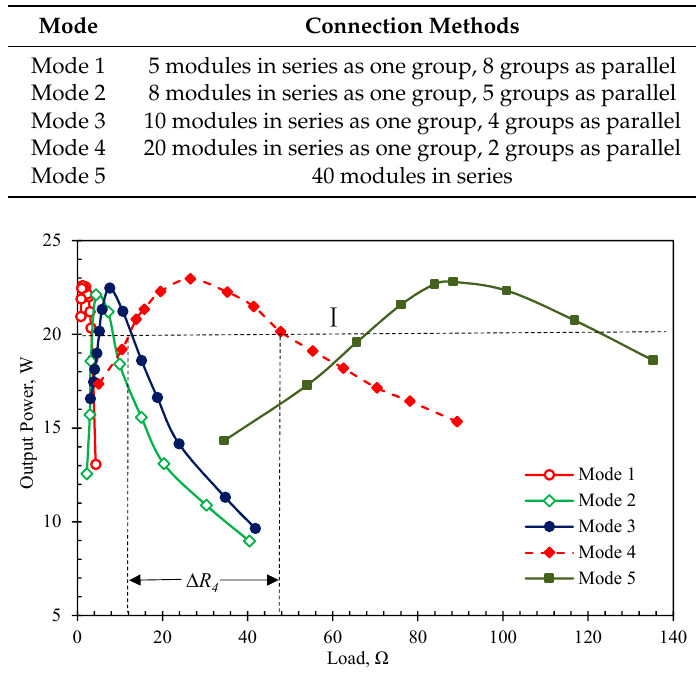
Table 2. Different connection methods among 40 modules.